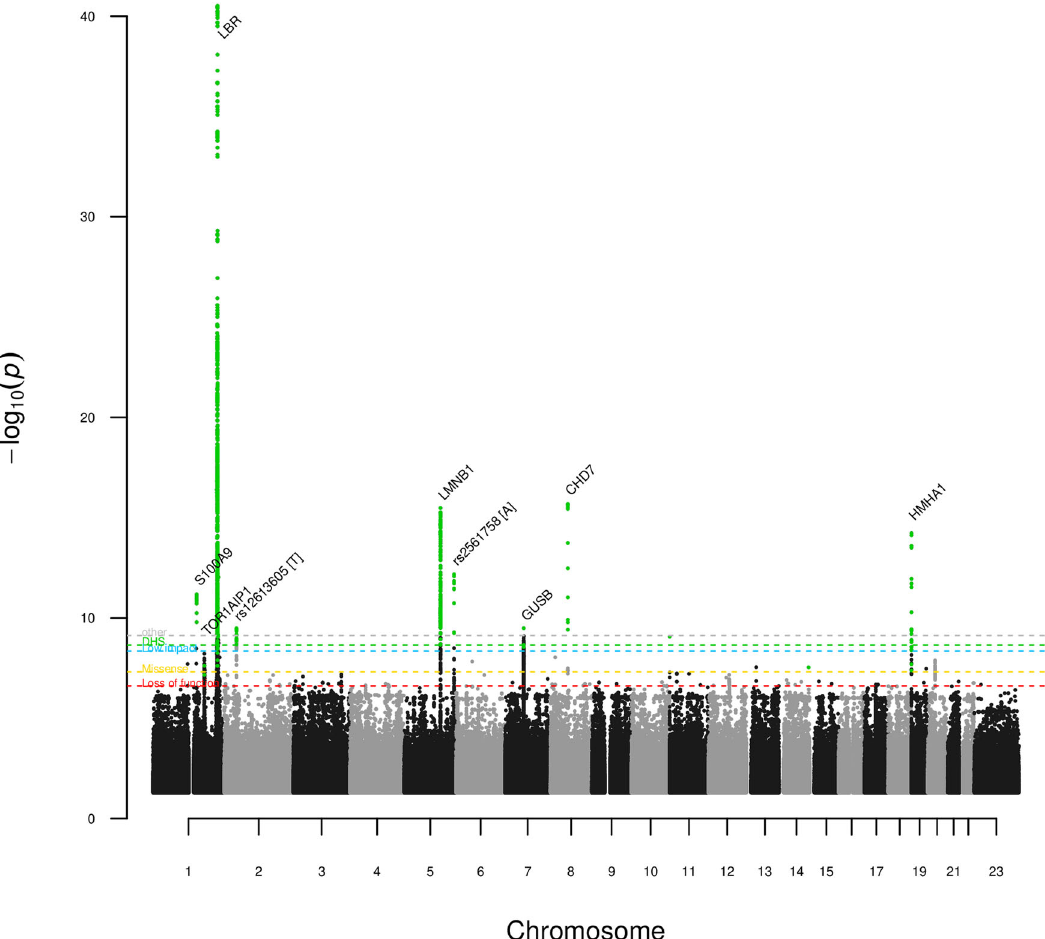
Fig. 1 Manhattan plot for GWAS of band neutrophil fraction in the Icelanders ( N = 88,101). Variants at nine loci reached genome-wide signi fi cance and are labeled. All variants with p values below their respective variant-class thresholds, indicated by horizontal dashed lines, are marked as green dots. Red dashed line: adjusted p value signi fi cance threshold for variants predicted to lead to loss-of-function ( p threshold = 2.4 × 10 − 7 ). Yellow dashed line: adjusted p value signi fi cance threshold for variants predicted to have moderate impact on gene function ( p threshold = 4.9 × 10 − 8 ). Cyan dashed line: adjusted p value signi fi cance threshold for variants predicted to have low impact on gene function ( p threshold = 4.4 × 10 − 9 ). Green dashed line: adjusted p value signi fi cance threshold for other variants in Dnase I hypersensitivity sites ( p threshold = 2.2 × 10 − 9 ). Gray dashed line: adjusted p value signi fi cance threshold for all other variants ( p threshold = 7.4 × 10 − 10 ). Variants are plotted by chromosomal position ( x axis) and − log10[ p ] values ( y axis). For clarity, only variants with p < 0.005 are